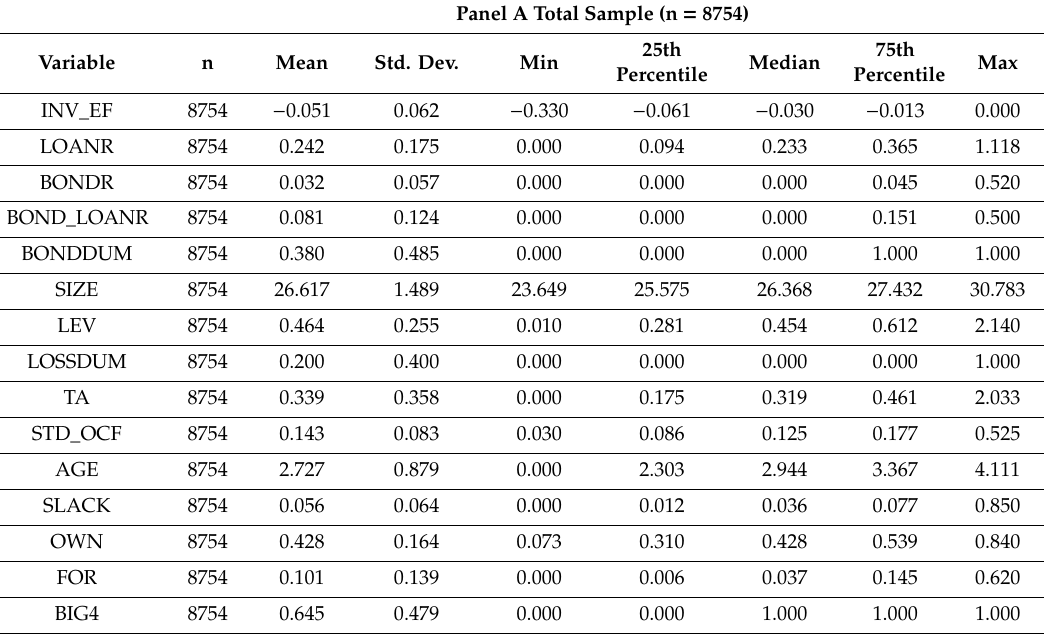
Table 3. Descriptive